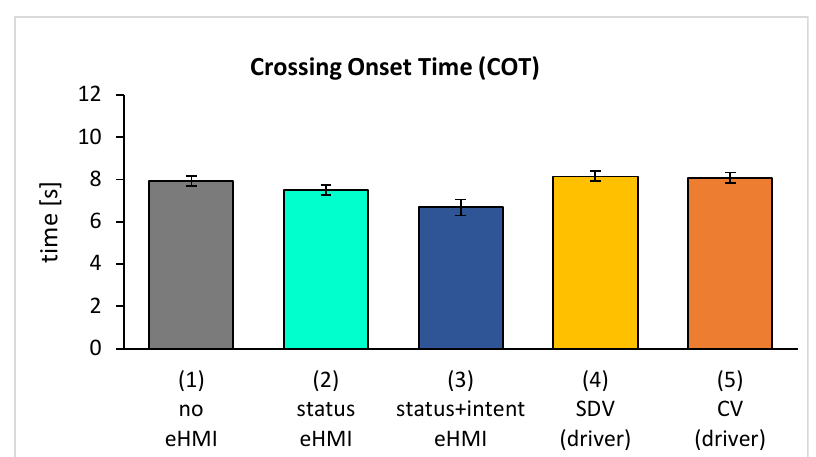
Figure 6. Mean crossing onset time (COT) for all yielding test conditions. Error bars: ±1 SE.